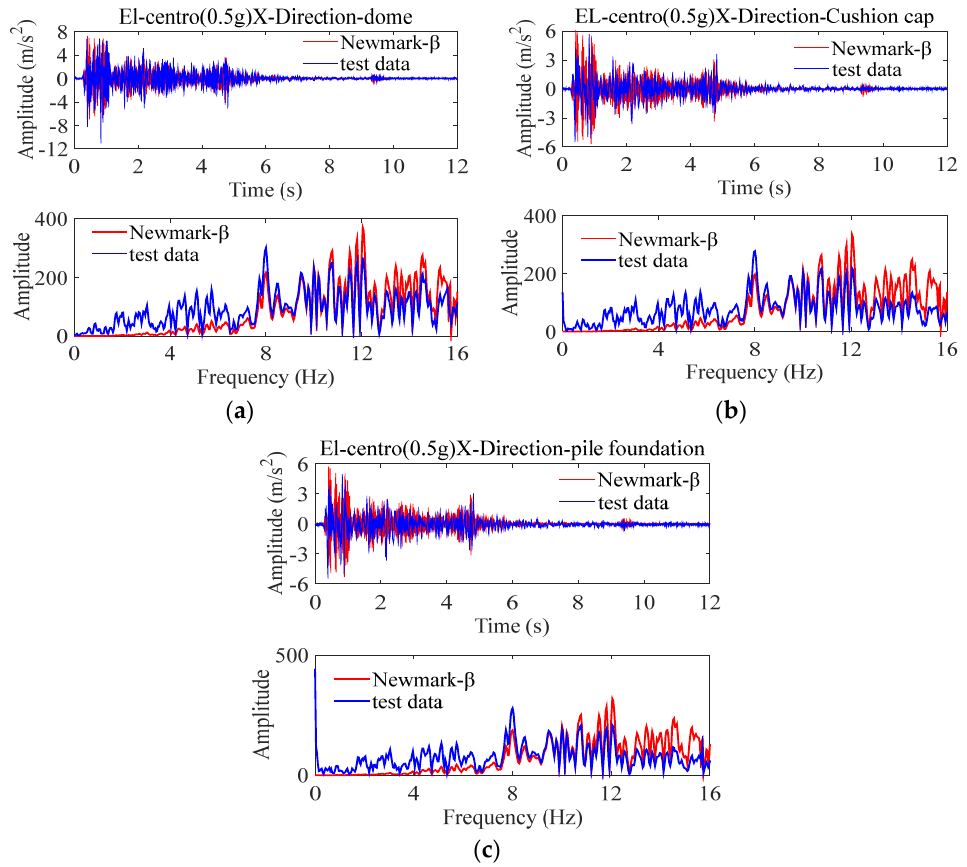
Figure 9. Comparison of shaking table test data and theoretical solution under the El − Centro wave: